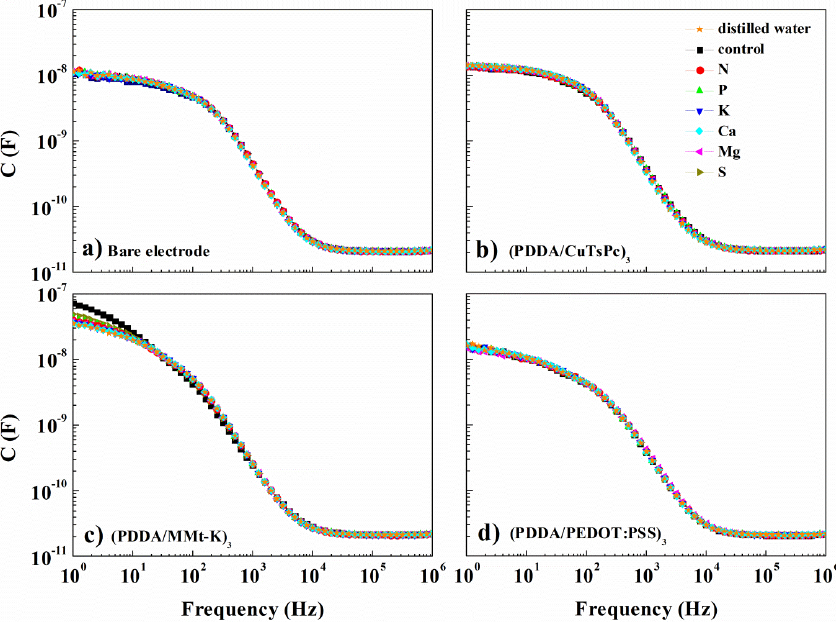
Figure 3. Capacitance spectra obtained during washing procedure within the microchannels using distilled water flow after analyzing all the soil samples (control, N, P, K, Ca, Mg, and S) with ( a ) bare electrode; ( b ) (PDDA/CuTsPc) 3 ; ( c ) (PDDA/MMt-K) 3 and ( d ) (PDDA/PEDOT:PSS) 3 . Since the spectra were not affected by the previous measurements and by the washing procedure, the sensing units can be reused.